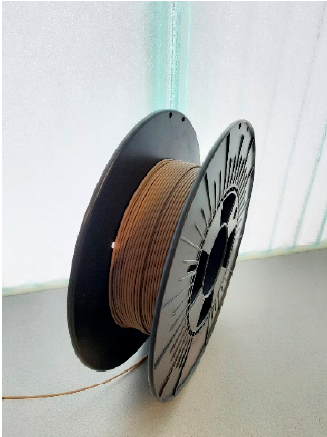
Figure 5. Self-made and spooled Meissner porcelain filament ø = 1.75 mm.